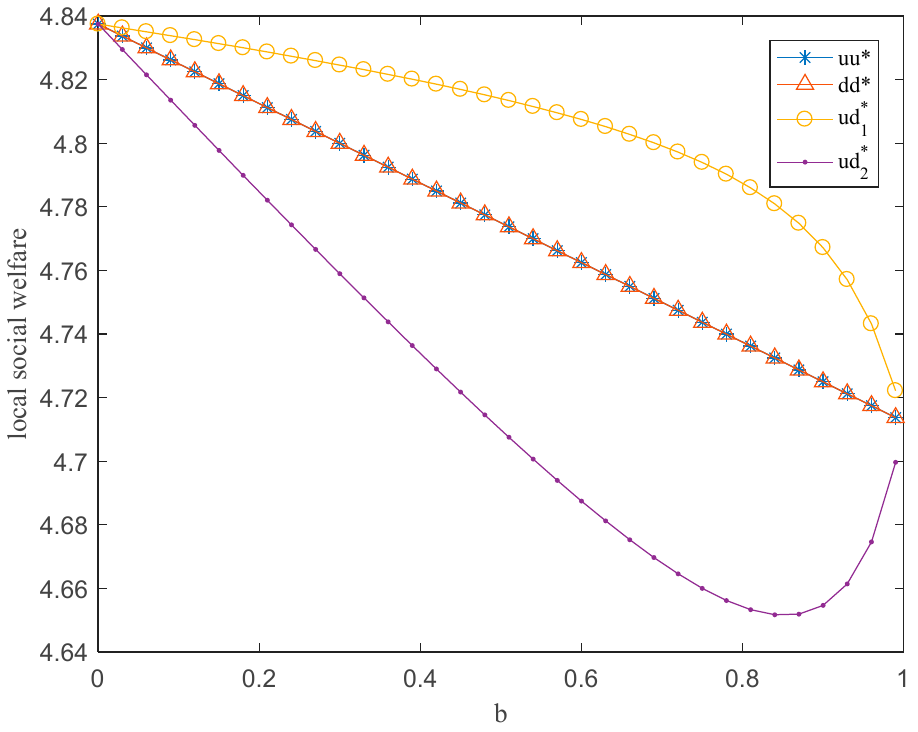
Figure 7. The local social welfare under different situations.